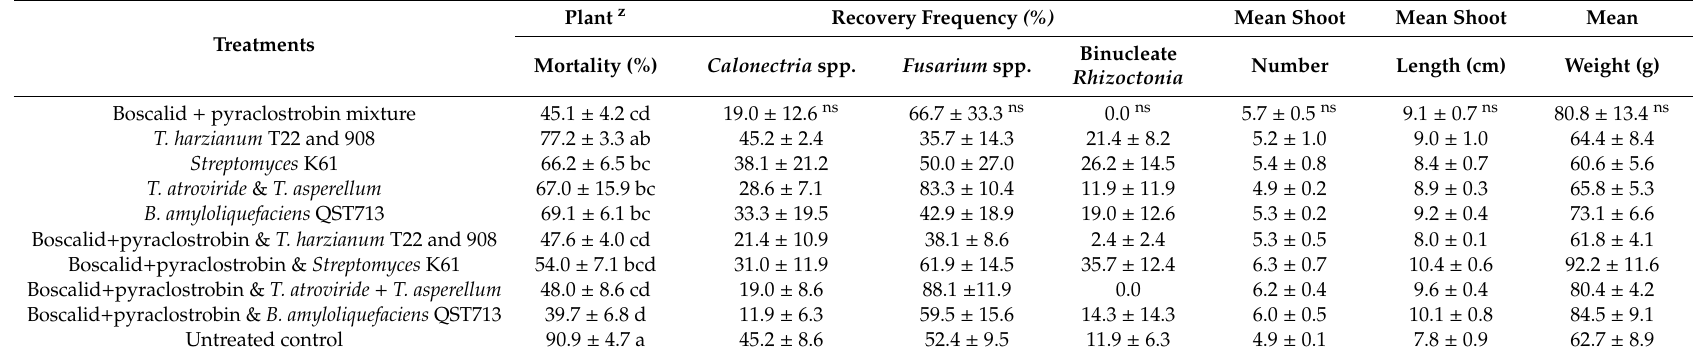
Table 2. E ffi cacy of treatments in reducing milkwort decline and agronomic parameters of plants in experiment II under artificial inoculation with Calonectria pauciramosa after 4 months.